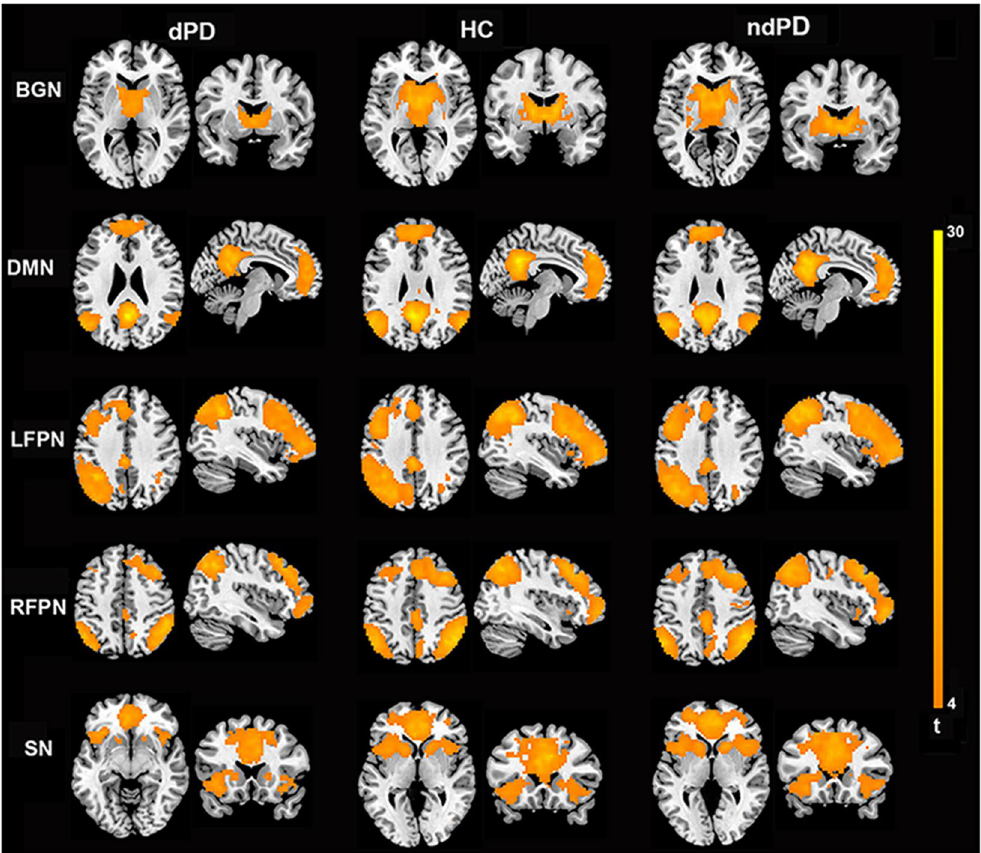
Figure 1. Spatial maps of BGN, DMN, LFPN, RFPN, and SN in dPD, HC, and ndPD group (one-sample t-test, p < 0.001, FDR corrected). The first two columns represented brain maps for dPD, middle two columns represented brain maps for HC, and last two column represented brain maps for